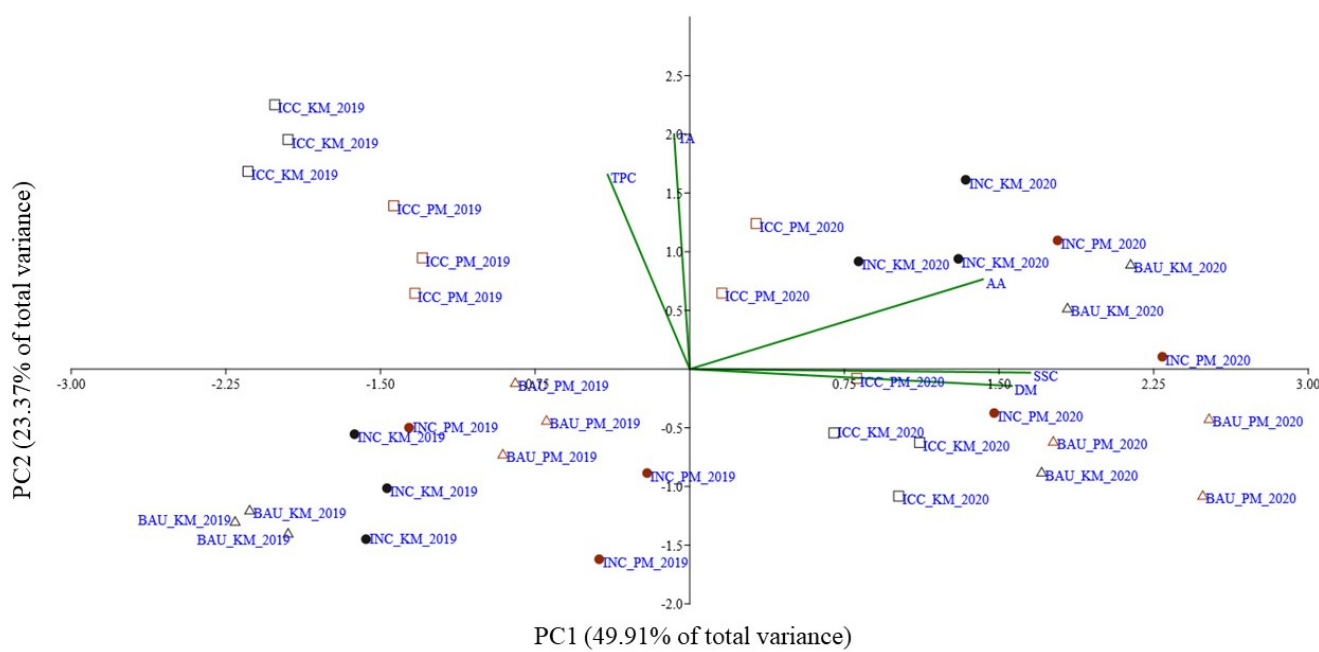
Figure 3. Biplot of Principal Component Analysis (PCA) performed on the two apricot cultivars (i.e., Kioto* KM and Pieve* PM), with three different system management systems (Business As Usual = BAU Innovative diversified system with Natural cover and Compost use = INC; Innovative diversified system with introduced Cover and Compost use = ICC), during 2019–2020. Legend: SSC = solid soluble content; TA = titratable acidity; DM = dry matter, TPC = total phenolic content; AA = antioxidant activity.